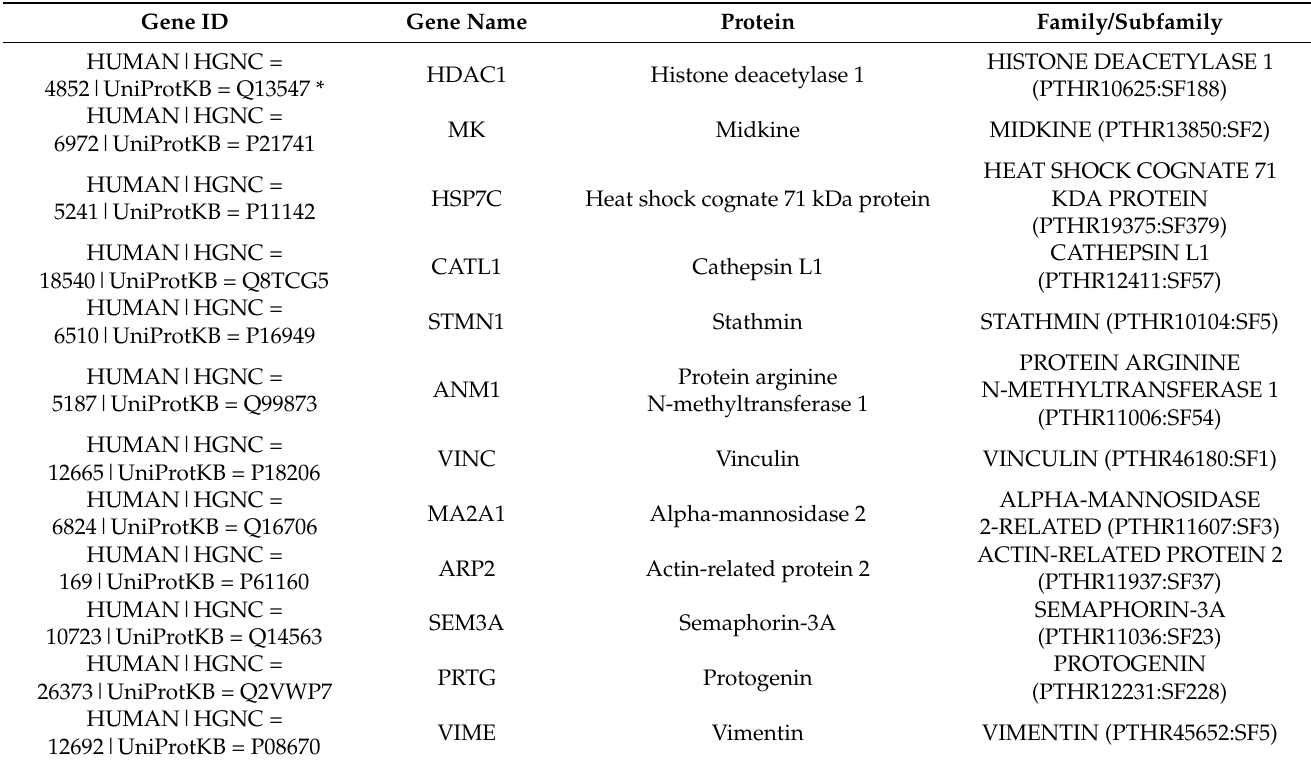
Table 1. Proteins of the conditioned medium of human PSA-NCAM + neural precursor cells identified by a proteomic